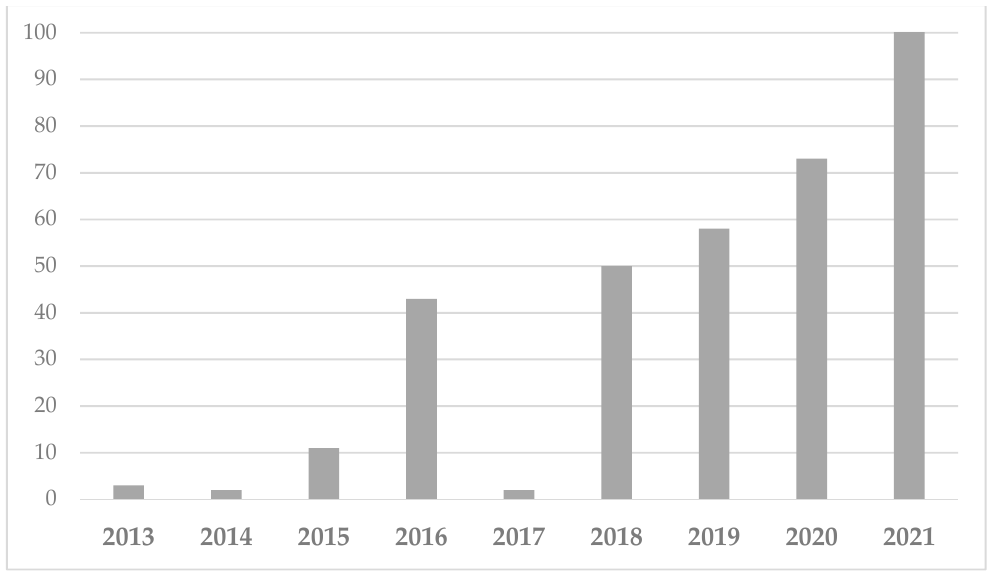
Figure 2. D istribution of relevant Reddit entries over time. Figure 2. Distribution of relevant Reddit entries over